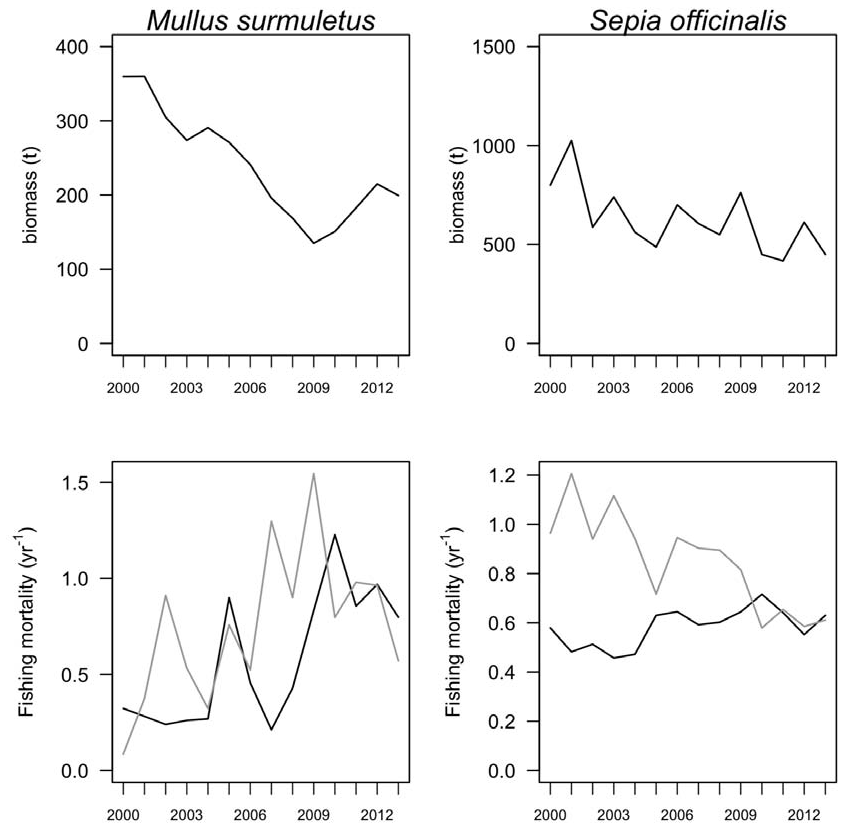
Fig. 8. – Vulnerable biomass (top) and fishing mortality by fishing gear (black, trammelnet; grey, bottom trawl) estimated for striped red mullet (left) and cuttlefish (right) based on the multi-annual generalized depletion